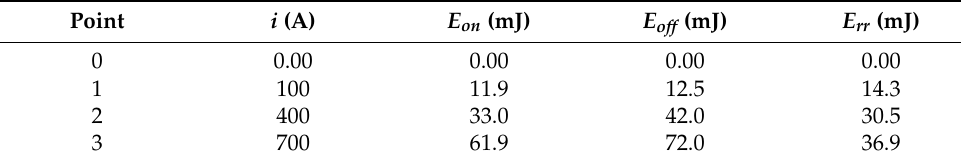
Table 3. Measurement points to characterize the switching losses.